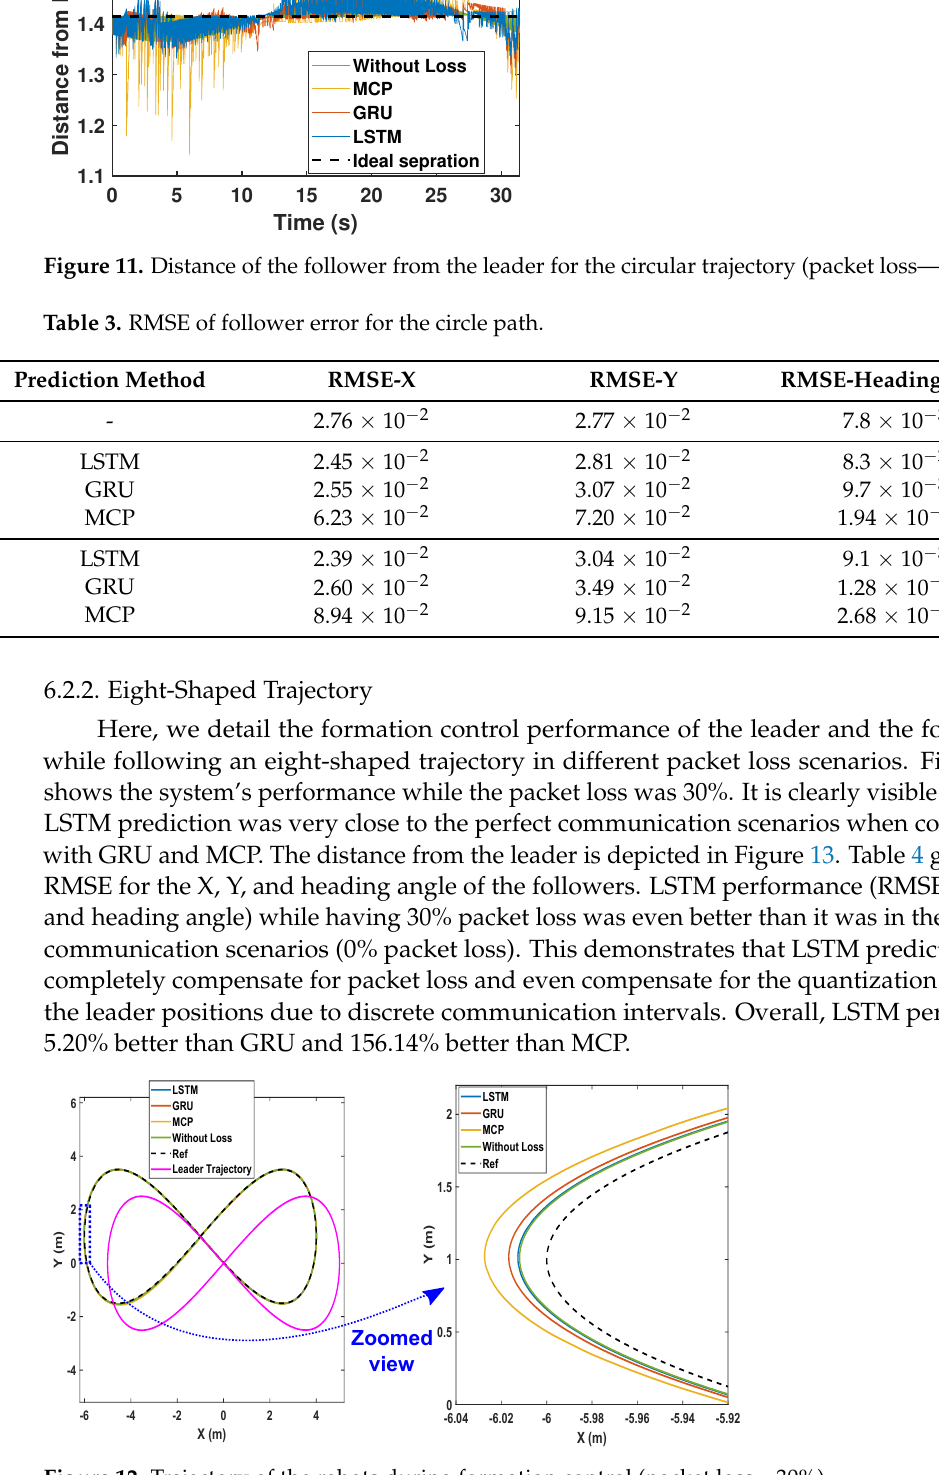
Figure 12. Trajectory of the robots during formation control (packet